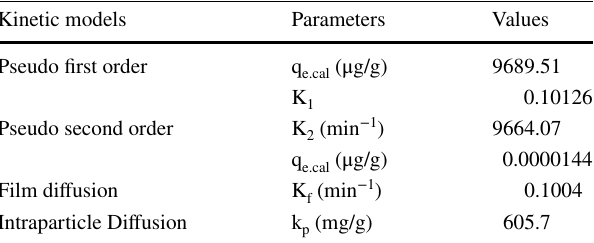
Fig. 7 Kinetic models a Pseudo first order plot, b Pseudo second order plot, c Film diffusion model and d Intra-particle diffusion plots for As (III) adsorption Table 1 Parameters of kinetic models Kinetic